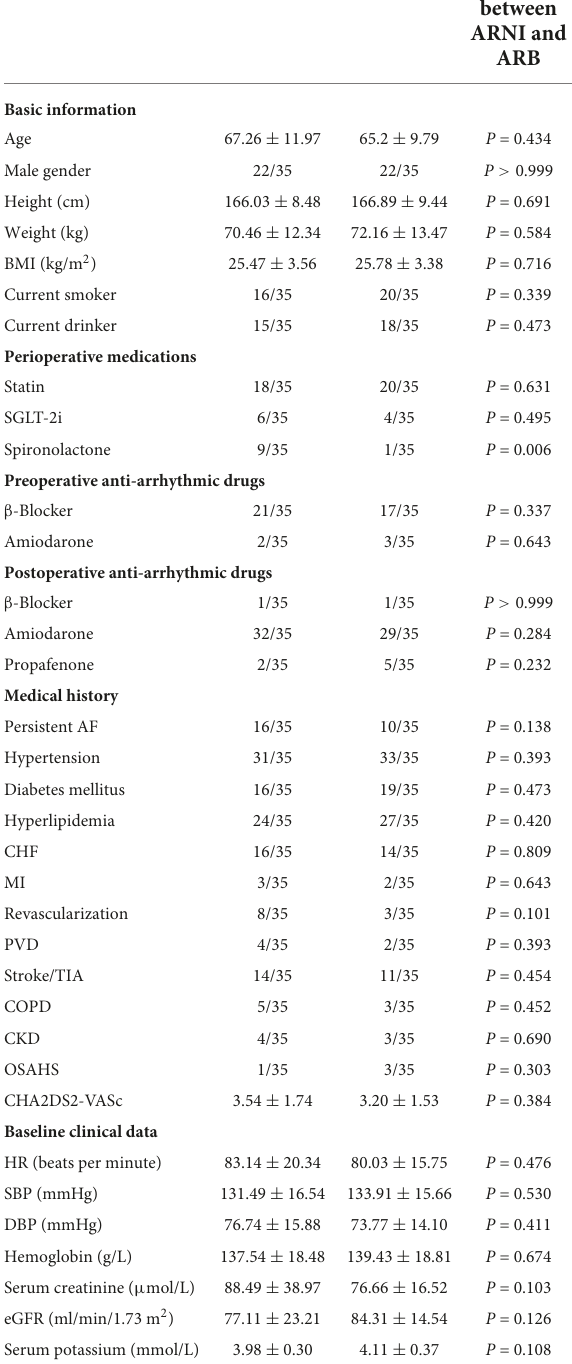
TABLE 1 Baseline clinical